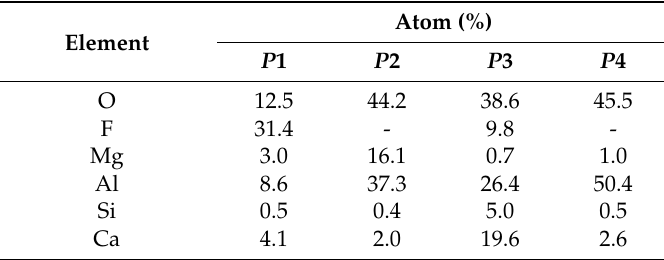
Table 1. Energy dispersive spectrometer (EDS) results of different points in specimen.